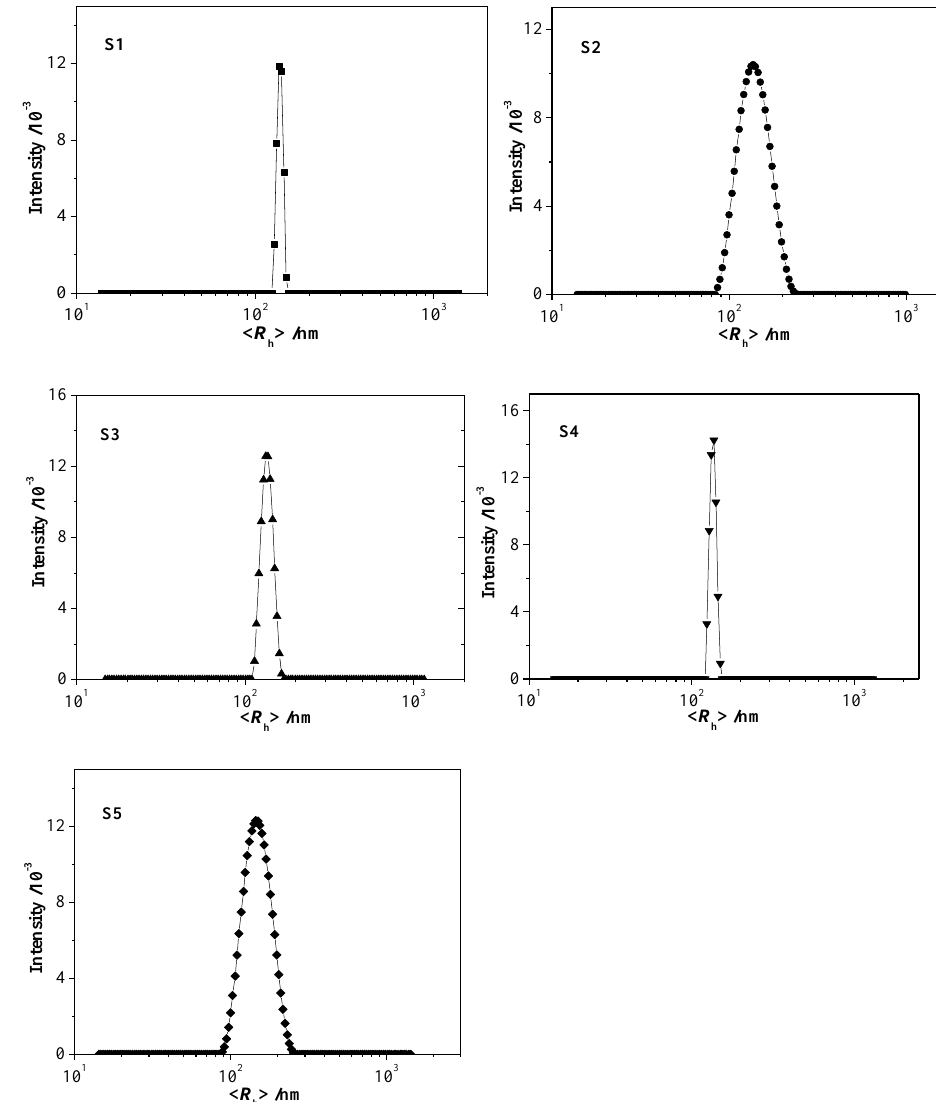
Figure 5. Size distribution of polymericmicelles (S1 to S5 samples, 0.02 gL −1 ). Table 2. Hydrodynamic radius of copolymeric micelles.